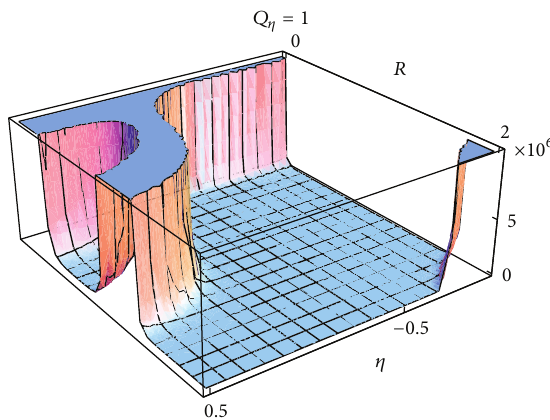
Figure 11: 4D Kretschmann invariant 𝜉 for 𝑄 𝜂 = 1 , for Λ = −1 .